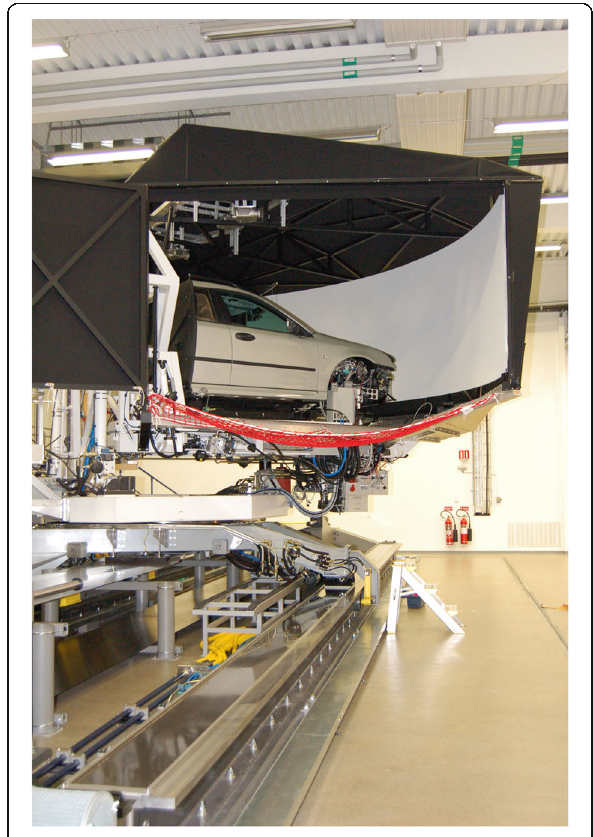
Fig. 1 VTI driving simulator III. The right-hand side of the projector dome is open and the car body (a SAAB 9 – 3) can be seen inside with the large video screen in